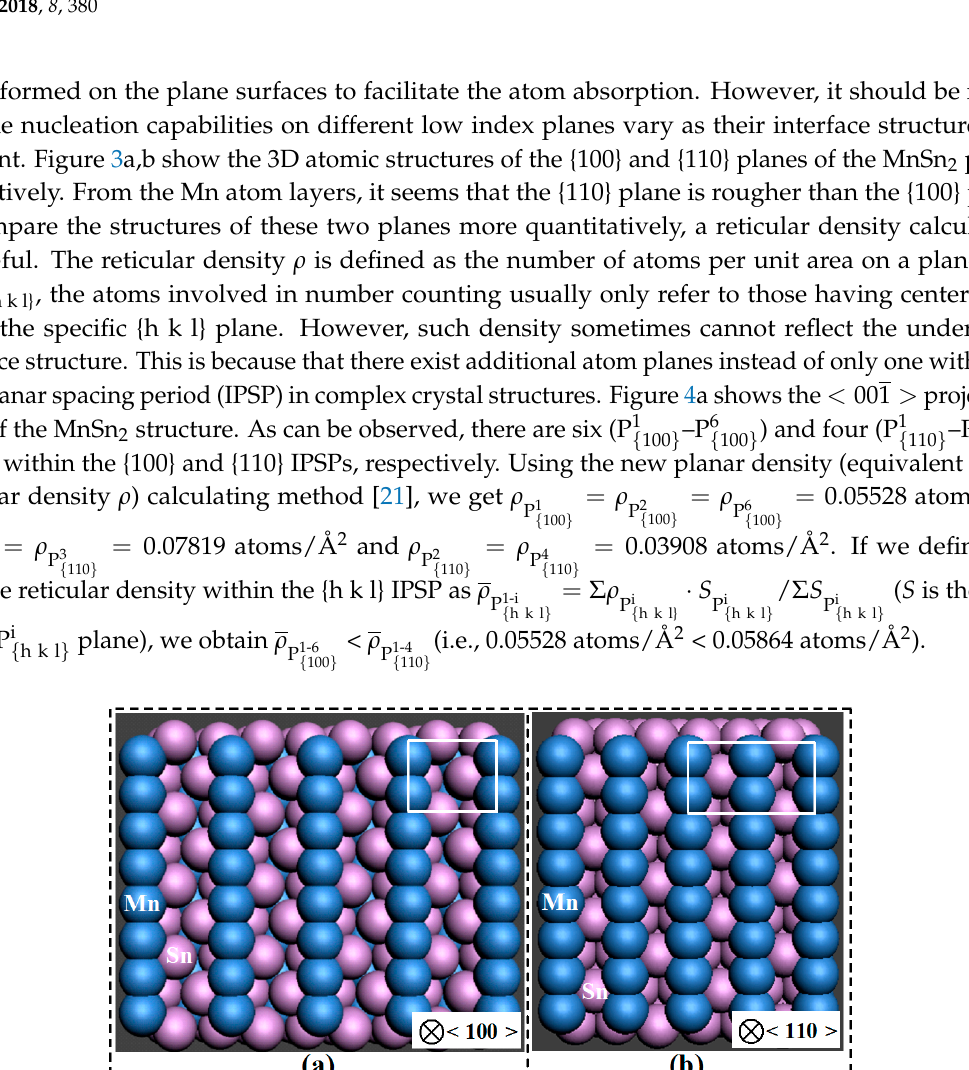
6 1 P 4 P 1 P ‐ -P 6 ) and (P 1 { -P 4 { ) atom planes within the {100} 6 1 P 4 P 1 P ‐ P ) and ( ‐ ) atom planes within the {100} { 100 } 100 } 110 } 110 } P ) and ( ‐ ) atom planes within the {100} {100} {110} {110} {100} {100} {110} {110} {100}